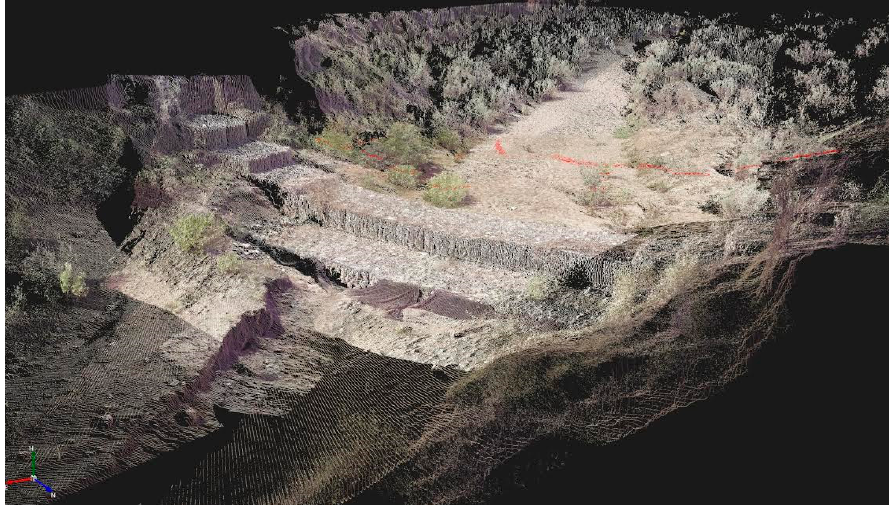
Figure 7. Image depicting the LiDAR-derived data collected at gabion #2 in Vaughn Canyon (Image by B. Forbes).